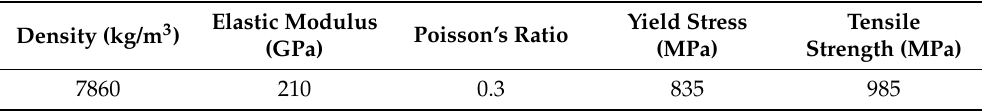
Table 2. Mechanical parameters of the material of the hanging mechanism.